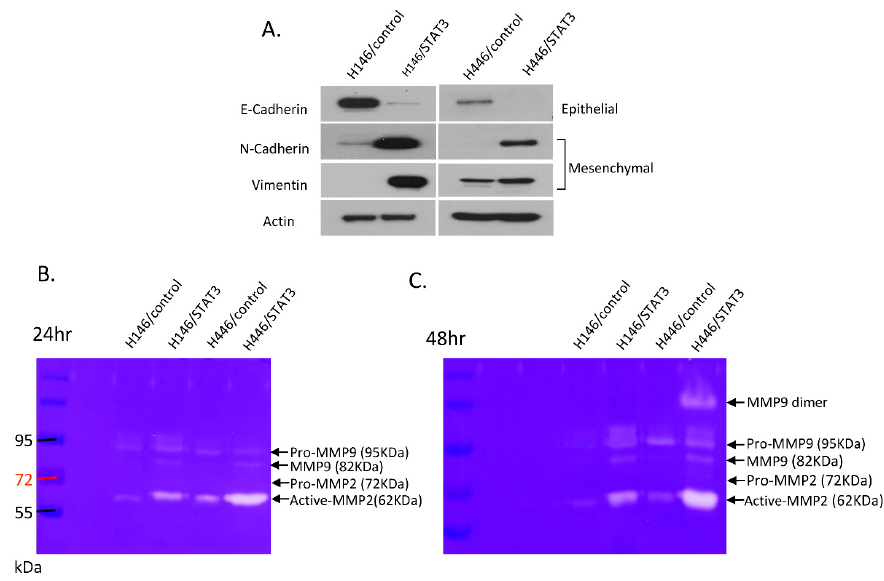
Figure 3. Epithelial–mesenchymal transition (EMT) marker expression changes after STAT3 over- expression in H146 and H446 cells. ( A ) E-cadherin protein expression decreased and N-cadherin and vimentin protein expression increased in STAT3-overexpressing H146 and H446 cells compared with control H146 and H446 cells. ( B , C ) STAT3-overexpressing H146 and H446 cells had increased matrix metalloproteinase-2 (MMP2) and matrix metalloproteinase-9 (MMP9) expression compared with control H146 and H446 cells. 3.4. Forced Overexpression of STAT3 Increased the Invasion Ability of H146 and H446 Cells Transwell assays were performed to investigate whether forced overexpression of STAT3 increased the invasion ability of H146 and H446 cells. Transwell assays showed that the number of cells invading the lower side of membranes obviously increased in STAT3-overexpressing H146 and H446 cells compared with control H146 and H446 cells by crystal violet staining (Figure 4A,C). In quantitative analysis of the Transwell invasion assay, the number of cells invading the lower side of membranes significantly increased in STAT3-overexpressing H146 and H446 cells ( p < 0.05) (Figure 4B,D). Our results verify that the forced overexpression of STAT3 increased the invasion ability of H146 and H446 cells.